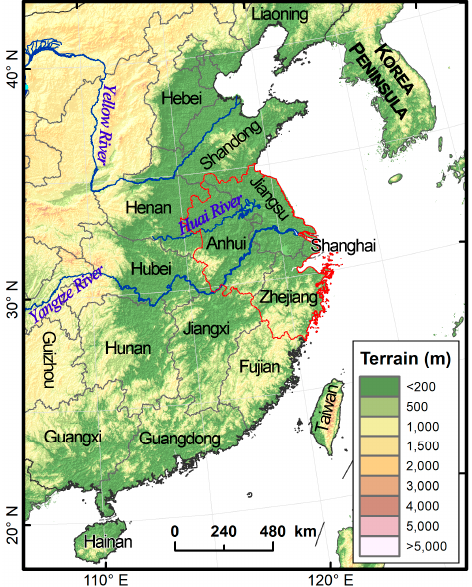
Figure 1. The migration arena of fall armyworm in East Asia. Most of East Asia is a large area of relatively flat land with few natural barriers to insect migration. Transported by the favorable winds associated with the movement of the Asian monsoon, invasive pest fall armyworm in this region takes regular, seasonal round-trip migration, as well as many other insects. The Yangtze River Delta located in East China, where the lower reaches of the Yangtze River meet the sea, is dominated by plain and includes Shanghai, Jiangsu, Zhejiang and Anhui provinces. Jiang–Huai region is the area between the Yangtze River and Huai river, rice is mostly transplanted after wheat is harvested in June. In the north of the Huai river, a large area of maize is planted in the summer, while a little maize is planted patchily in Jiang–Huai region and the south of the Yangtze